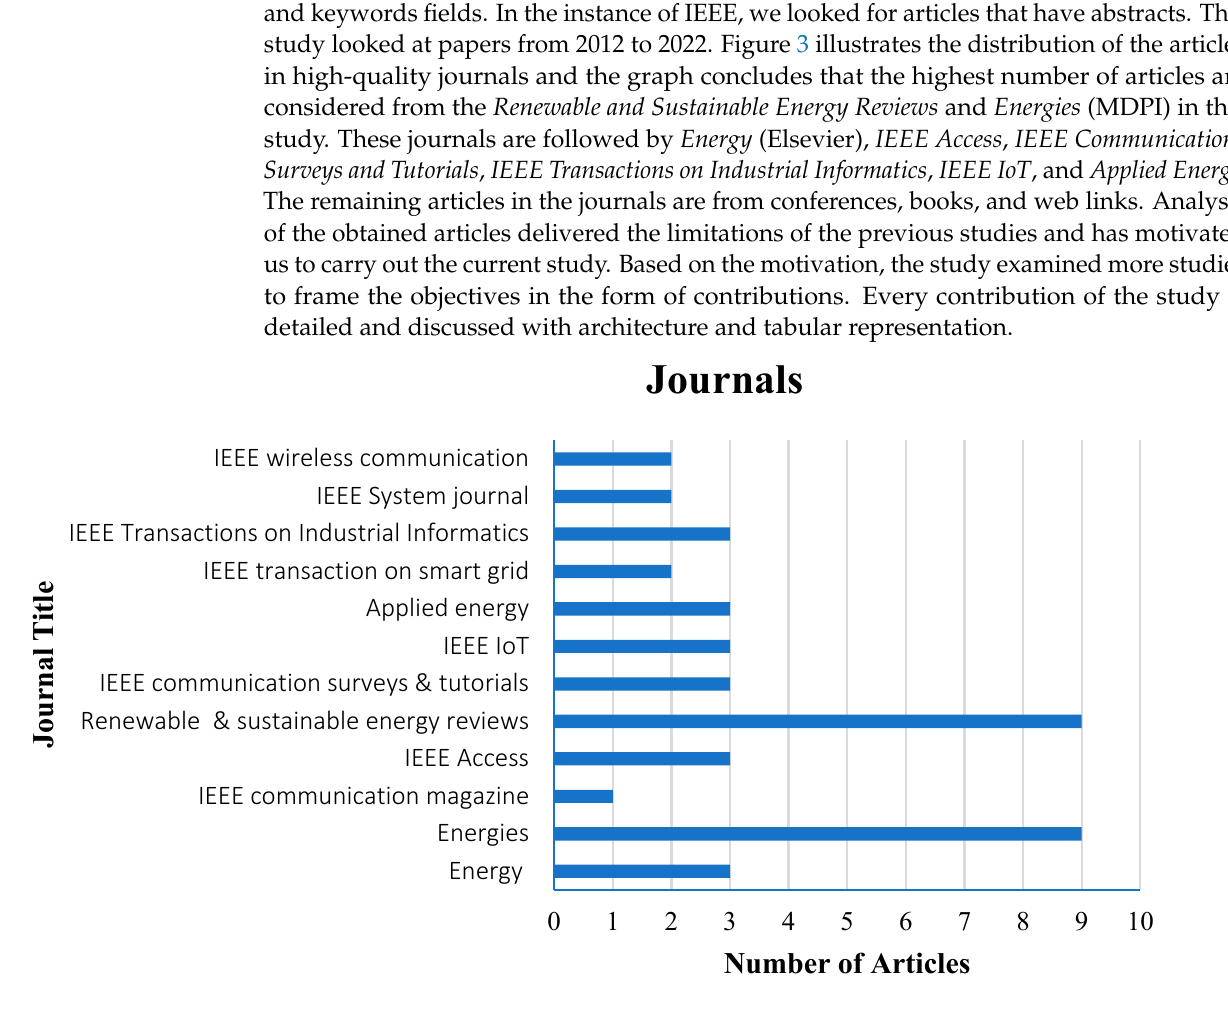
Figure 3. Articles distribution based on journal.